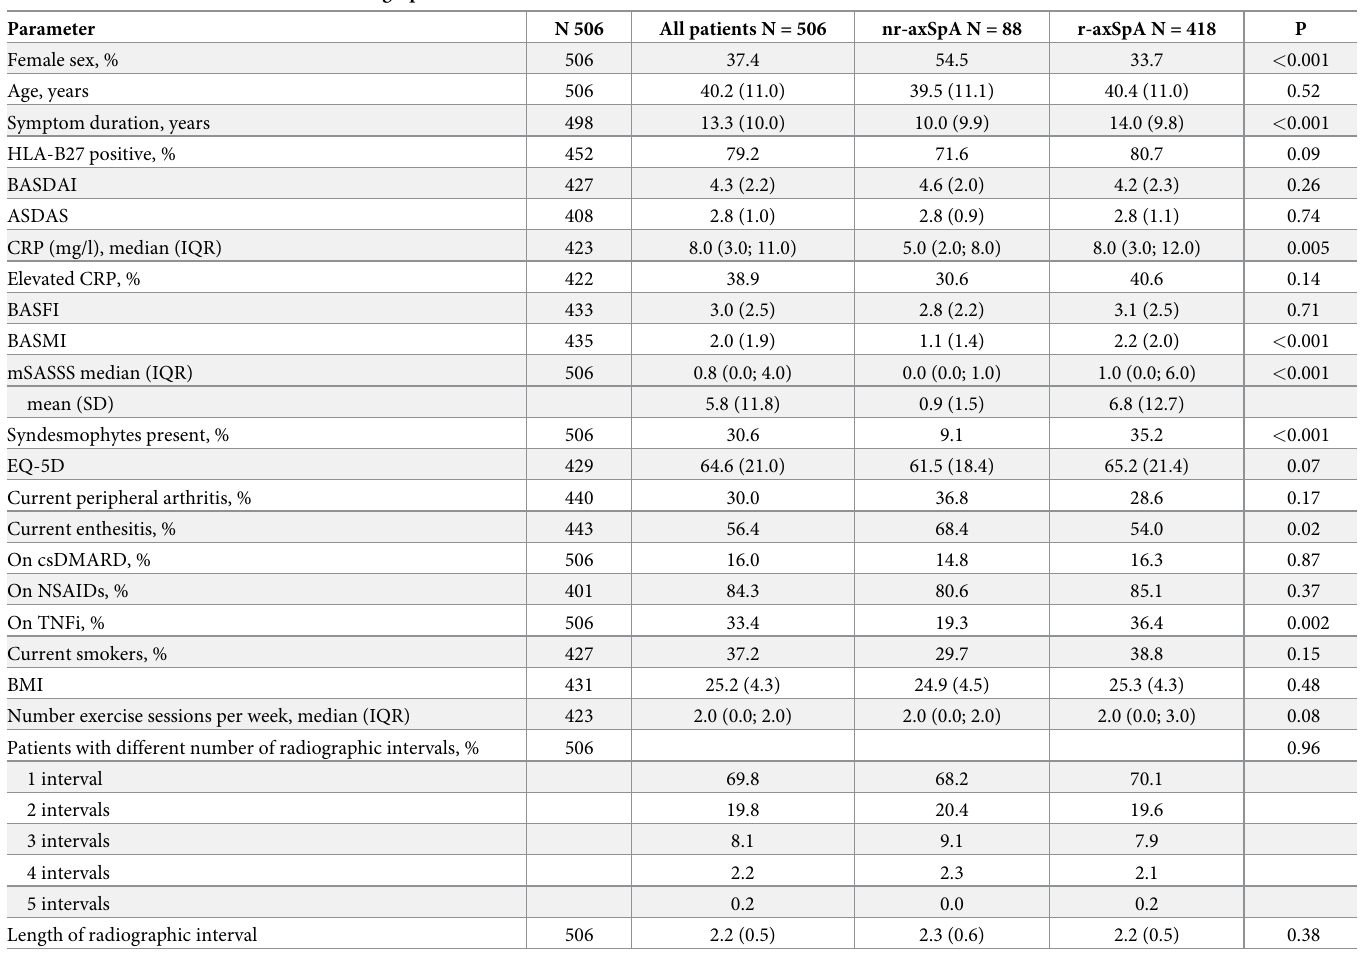
Table 1. Baseline characteristics at first